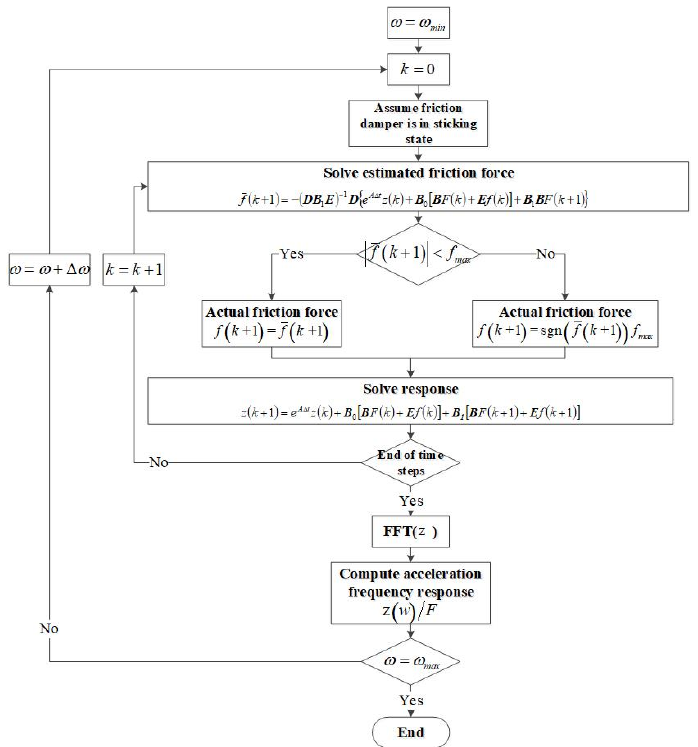
Figure 7. Computational flowchart for the nonlinear analysis method of frictional force.